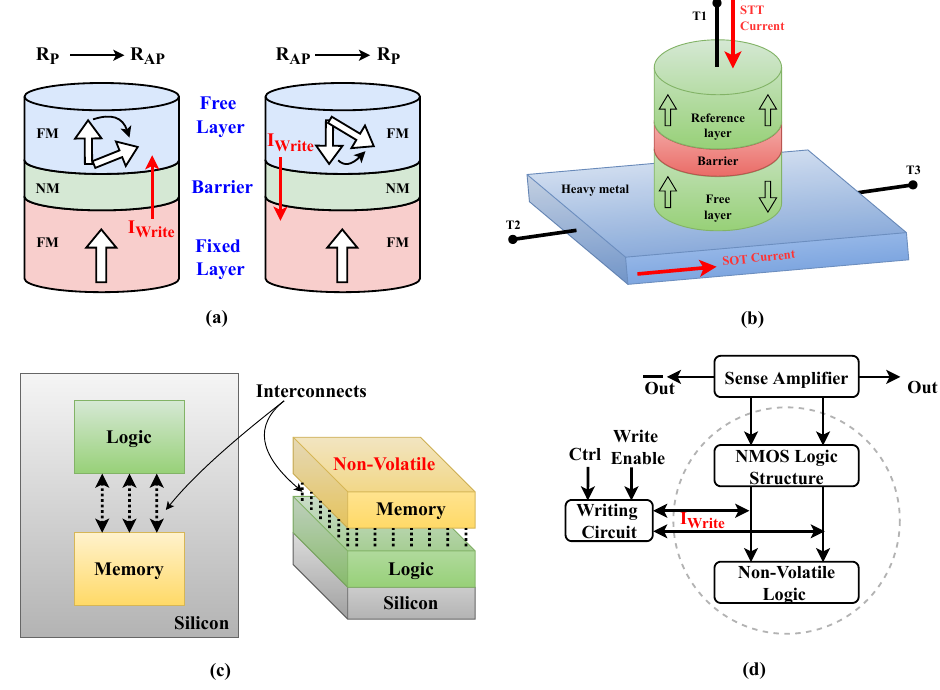
Figure 1. ( a ) Two-terminal p-MTJ construction and switching. ( b ) Three-terminal p-MTJ structure. ( c ) Von-Neumann and logic-in-memory architecture. ( d ) Hybrid CMOS-MTJ structure. A hybrid CMOS-MTJ approach-based the LIM architecture is shown in Figure